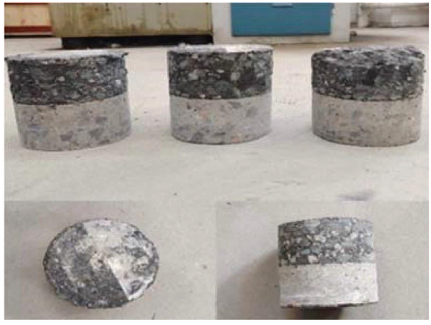
Figure 3: Drill core samples.